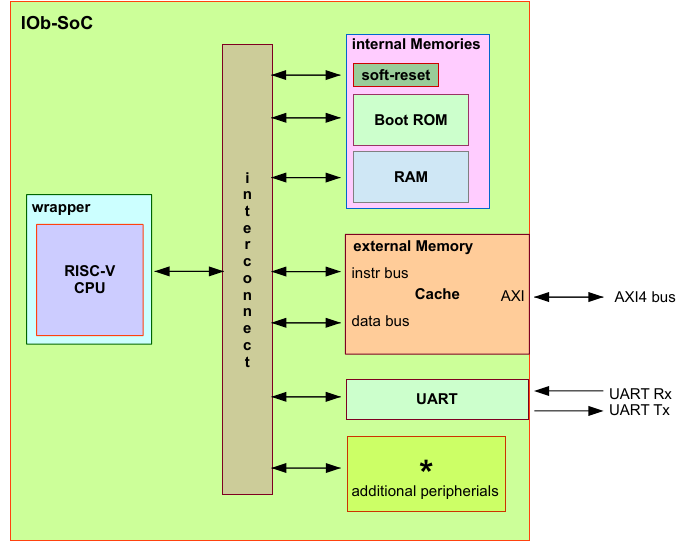
Figure 10. IOb-SoC module